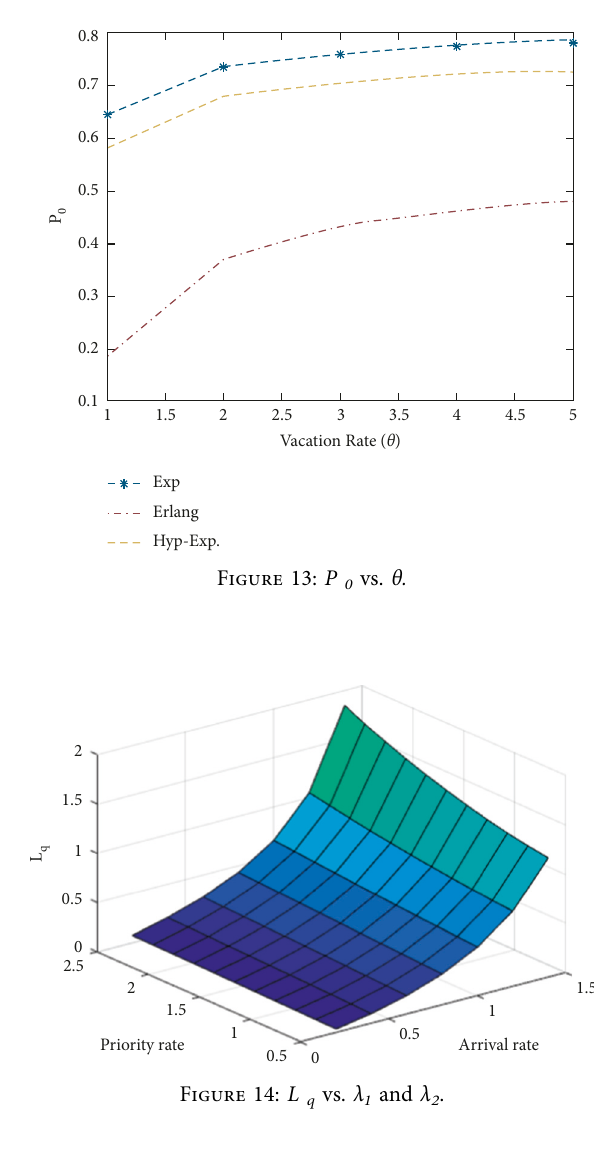
Figure 14: L q vs. λ 1 and λ 2 .